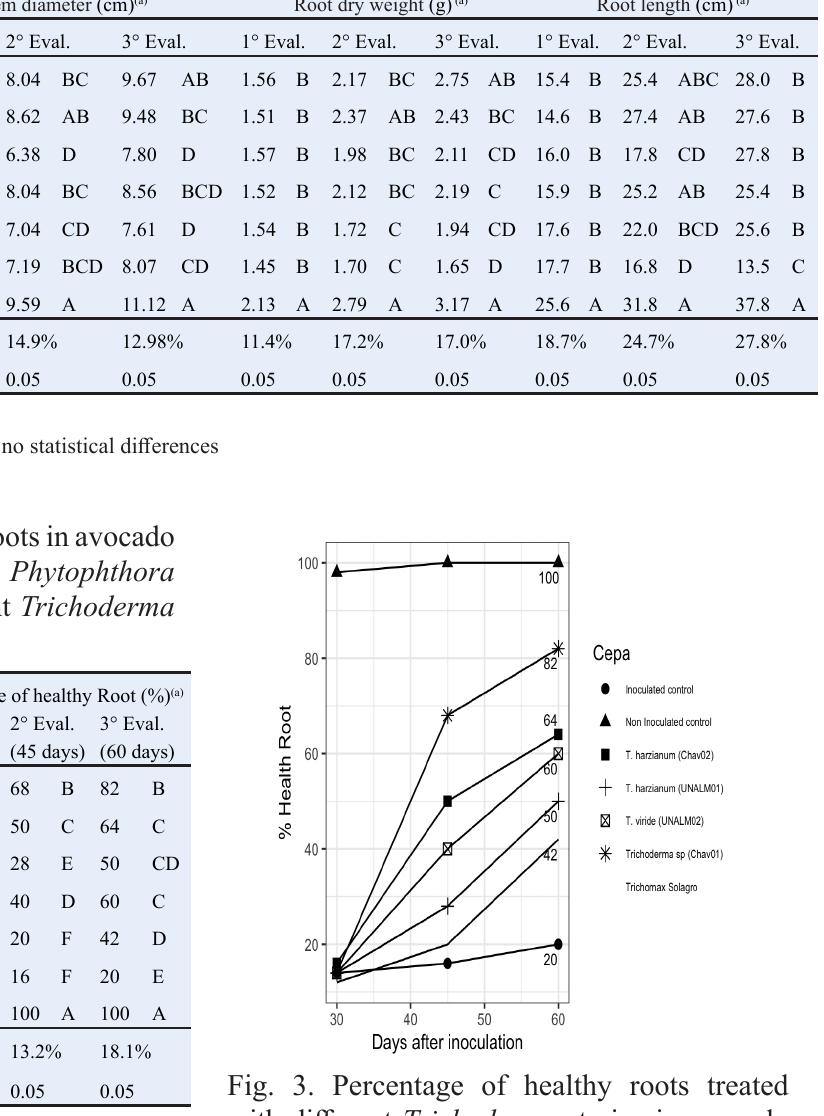
Table 2. Biometric parameters: Stem diameter (cm), root dry weight (g) and root length (cm) in avocado seedlings inoculated with Phytophthora cinnamomi treated with different Trichoderma strains Stem diameter (cm) (a) Treat. Antagonist Strain